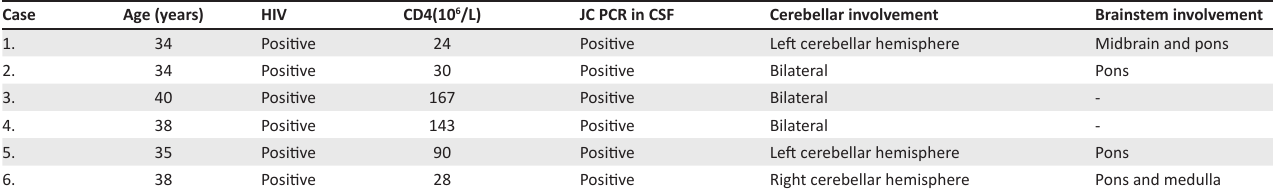
TABLE 2: Clinical and magnetic resonance imaging findings of the patients.